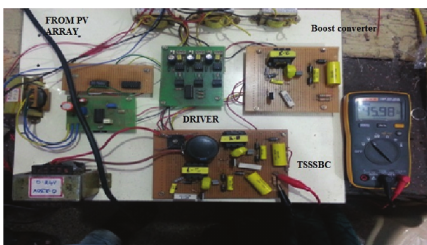
Figure 19: Hardware setup for TSSSBC.